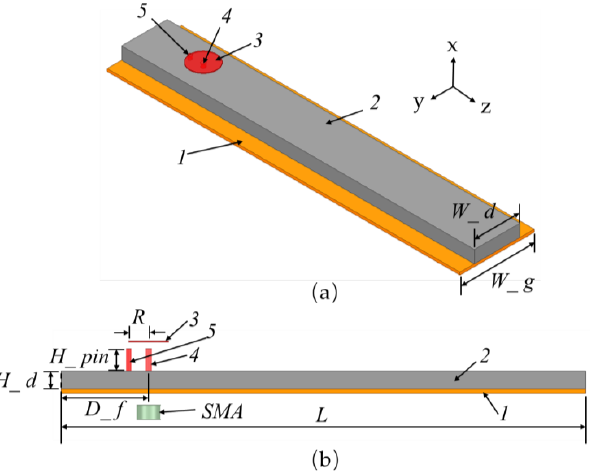
Figure 2. Structure of the low profile surface-wave antenna: ( a ) main view, ( b ) side view.